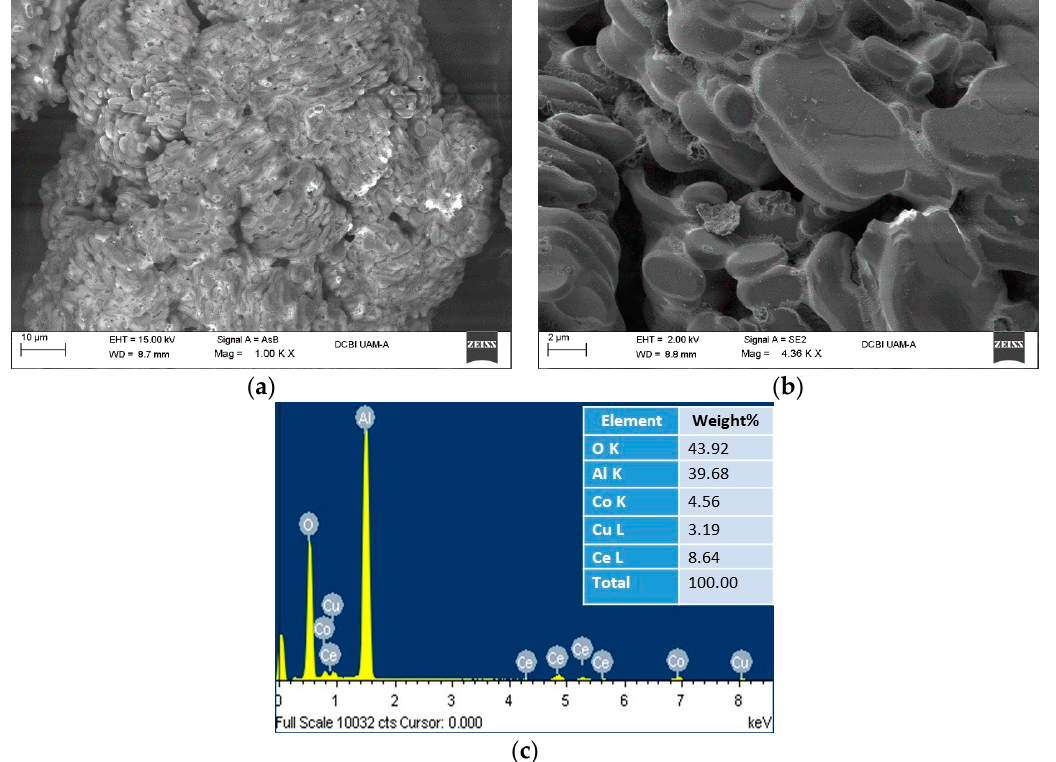
Figure 2. SEM analysis for catalyst Ce-Cu-Co/ α -alumina: ( a ) AsB detector (1000X), ( b ) SE2 detector (4360X), ( c ) EDS detector (elemental